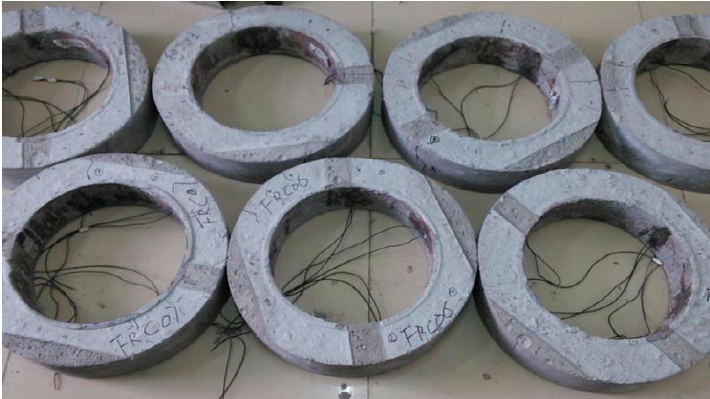
Figure 5. Specimens for the plat-ring-type test.